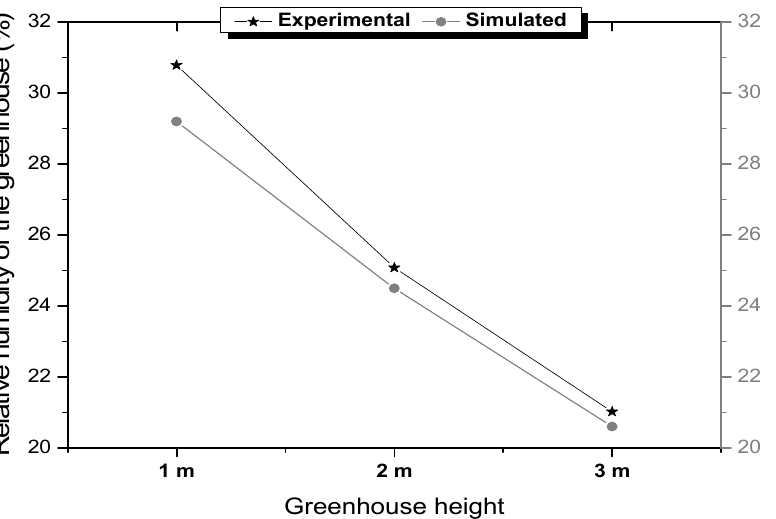
Figure 6. Evolution of the simulated and measured values of the relative humidity as a function of the greenhouse height (1 m, 2 m, and 3 m) at noon.